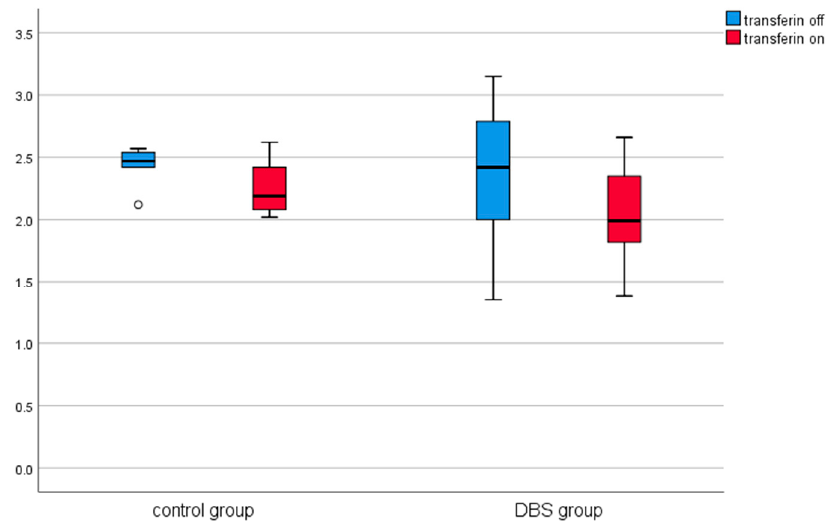
Figure 3. Effect of lesional surgery and DBS on transferrin levels (g/L). (°—outliers ≦ 3SD, *—out- liers > 3SD).